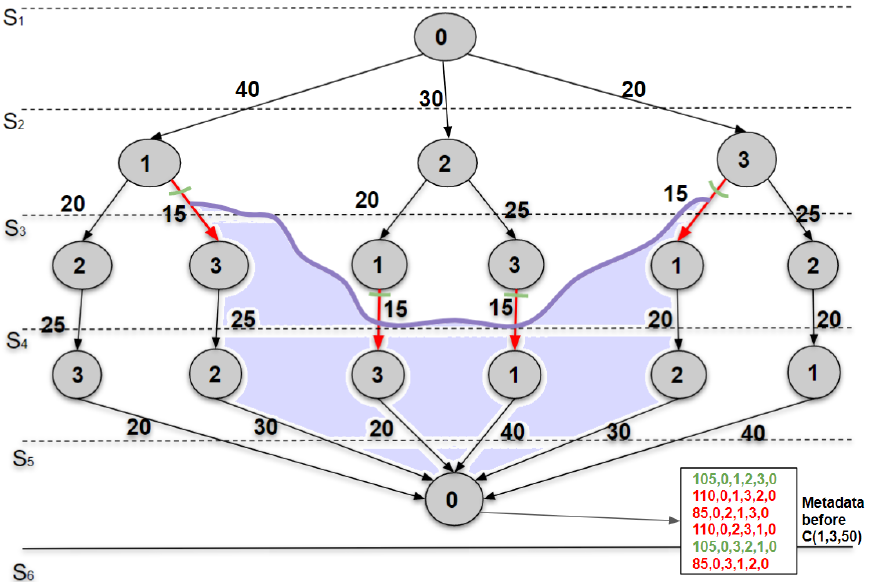
Figure 2. Search tree with all the possible permutations of TSP tours in a four-vertex graph. Each tour begins with source vertex 0 and ends at source vertex 0. For a four-vertex graph, there will be six possible tours. The purple area shows the region affected by the update